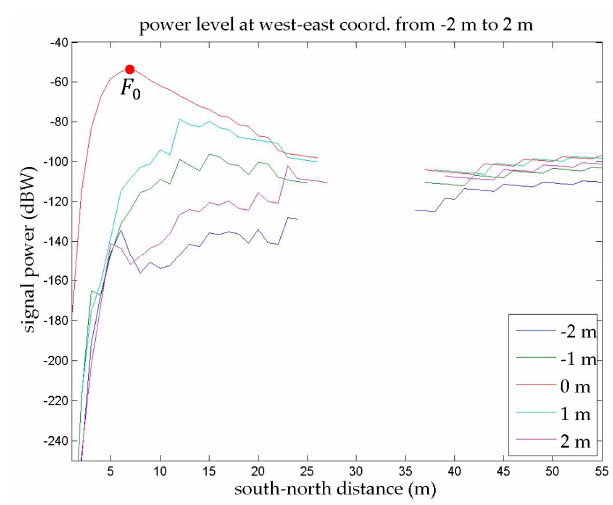
Figure 9. IF power distribution for the strong scattering area. The scattering power from the dominant facet located at (0, 7) is the strongest.